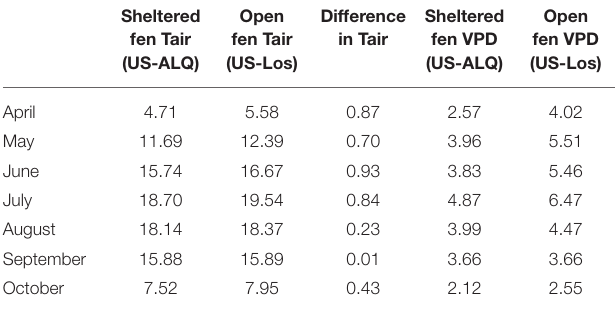
TABLE 3 | Average monthly air temperature and VPD at both sites.